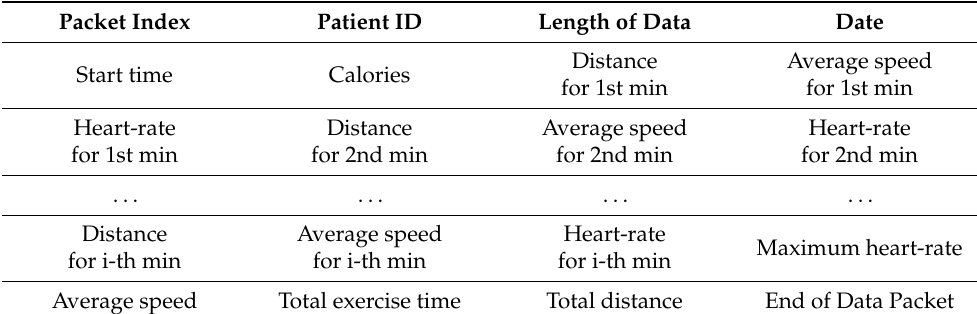
Table 4. A data packet format for the proposed IoT health DAQ